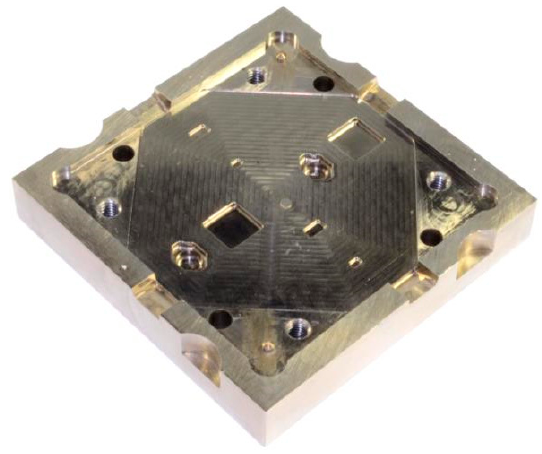
Figure 3. Molding tool insert for a 0.25 mm thick encapsulation.